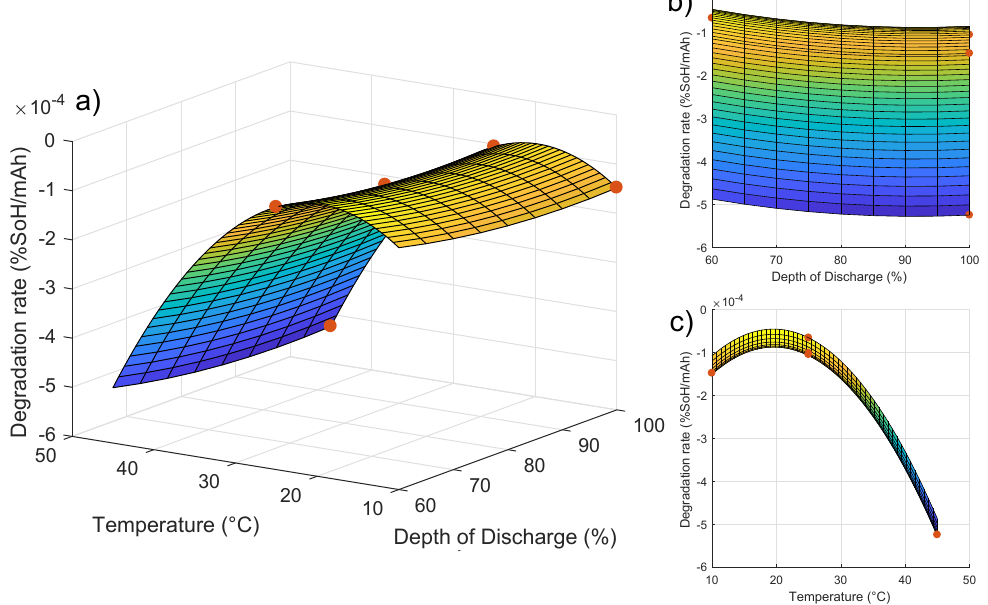
Figure 14. ( a ) The capacity degradation rate expressed in % SoH / mAh of discharged capacity throughput, mapped by the developed degradation rate Equation (4) at C/3 between 10 ◦ C and 45 ◦ C and 60% and 100% DoD. 2D plots of the degradation rate’s dependencies on ( b ) depth of discharge and ( c ) temperature, where red dots mark experimentally-observed degradation rates (Table